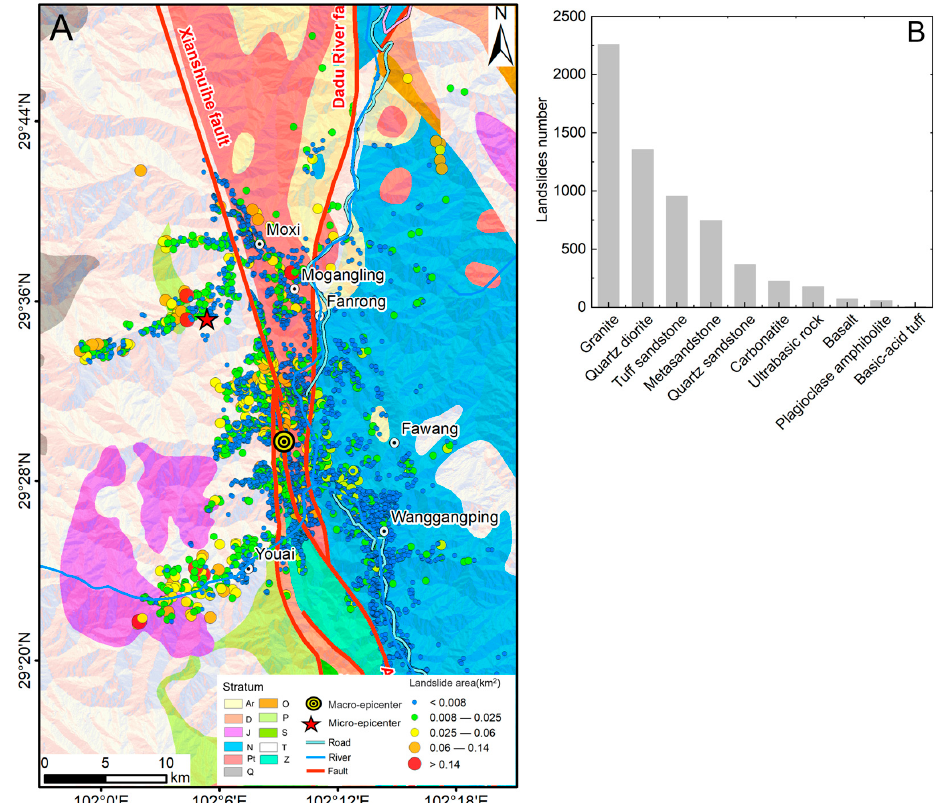
Figure 15. ( A ) coseismic landslide distribution with lithology; ( B ) correlations between landslide number and lithology.